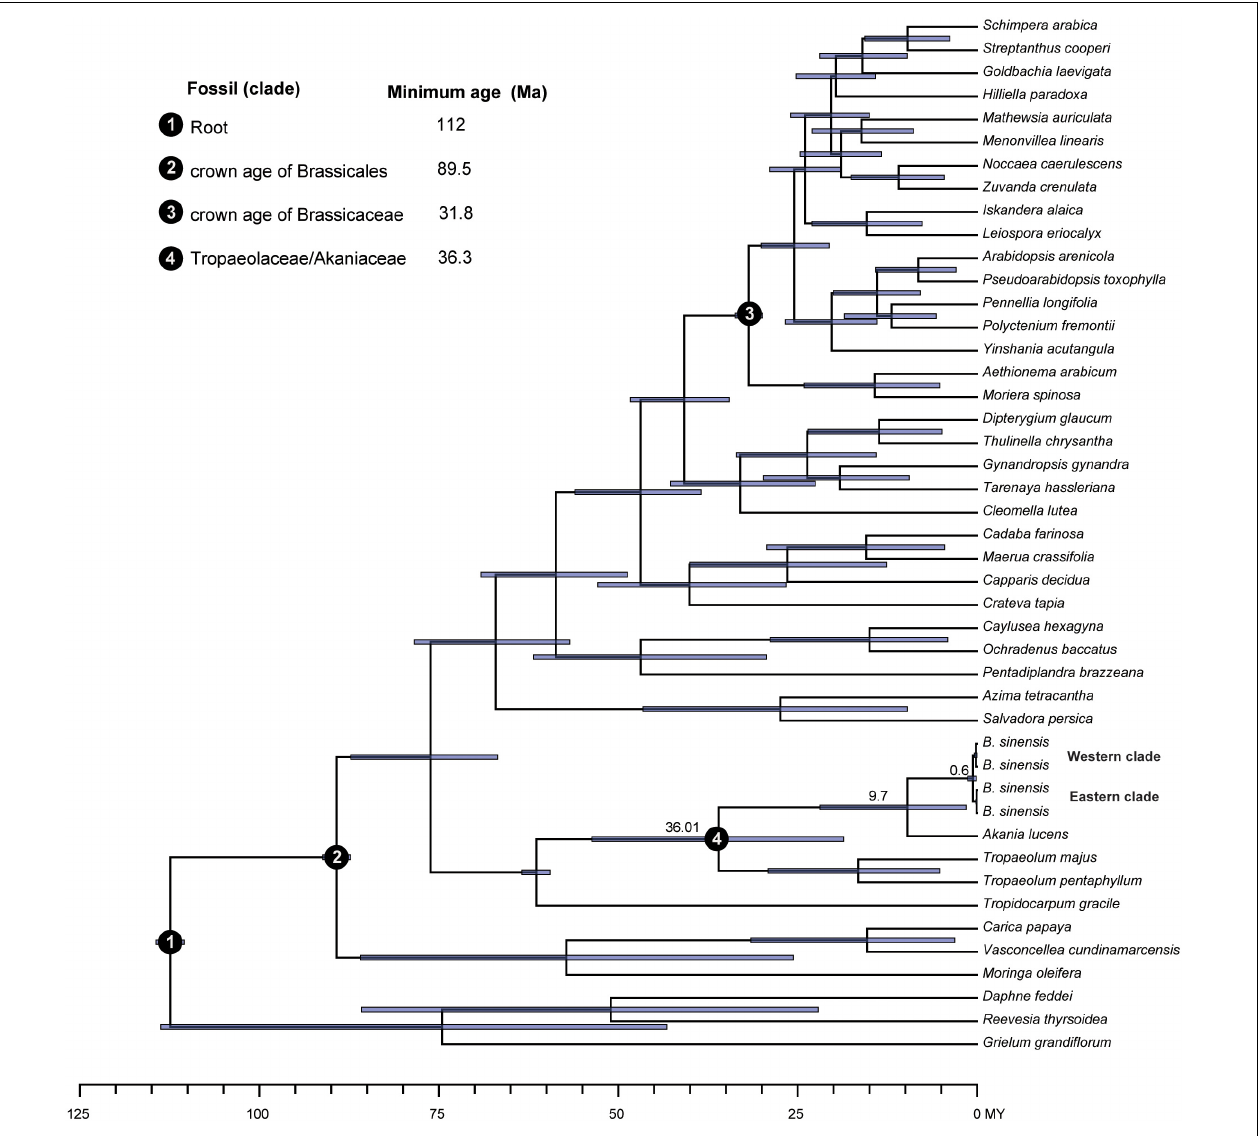
FIGURE 9 | Divergence times of Brassicales obtained from BEAST analysis. Mean divergence time of the nodes is shown next to the nodes, while the blue bars correspond to the 95% highest posterior